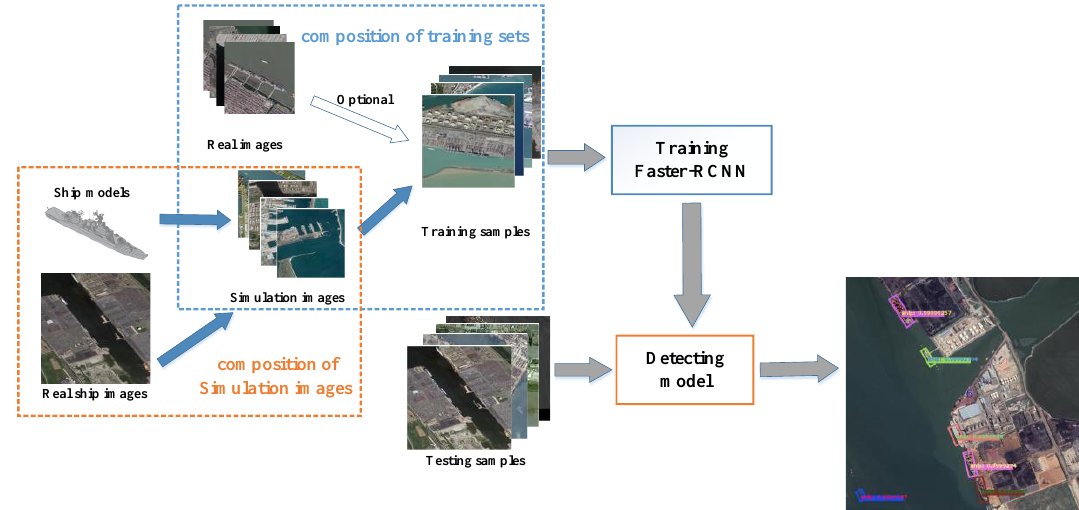
Figure 1. The framework of the proposed ship detection method.